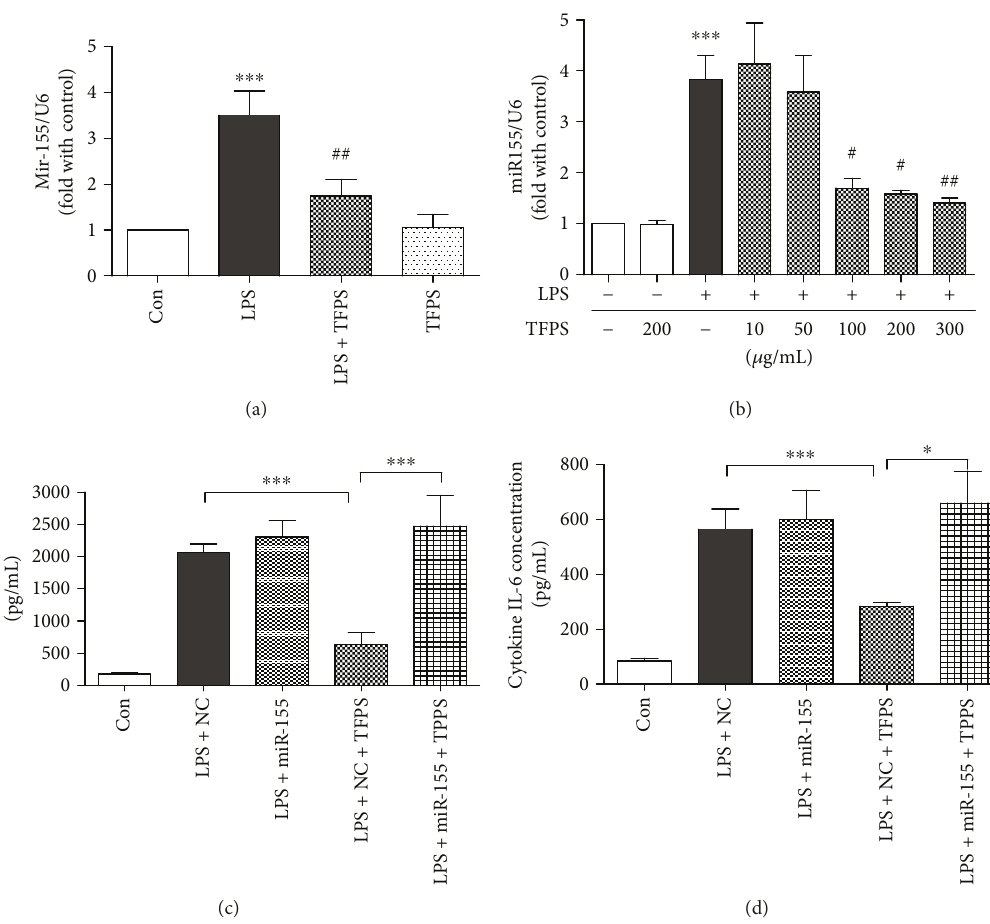
Figure 7: TFPS attenuates LPS-induced in fl ammation reaction by inhibition of miR-155. (a) The miR-155 expression levels in control, LPS- treated (1 μ g/ml), TFPS-treated (200 μ g/ml), and TFPS-pretreated (200 μ g/ml)+1 μ g/ml LPS-treated (LPS+ TFPS) cells, as assessed by real- time RT-qPCR ( n = 4 , ∗∗∗ P < 0 001 versus control; ## P < 0 01 versus the LPS +TFPS group). (b) The miR-155 expression levels in control, TFPS-treated (200 μ g/ml), LPS-treated (1 μ g/ml), and 1 μ g/ml LPS-treated cells following TFPS pretreatments (10, 50, 100, 200, or 300 μ g/ ml) of RAW264.7 cells for 1 h ( n = 3 , ∗∗∗ P < 0 001 versus control; # P < 0 05 , ## P < 0 01 versus the LPS group). (c) ELISAs of TNF- α and IL-6 in control, LPS+NC, LPS+ miR-155, LPS+ NC +TFPS, and LPS+ miR-155+TFPS groups ( n = 4 , ∗ P < 0 05 , ∗∗∗ P < 0 001